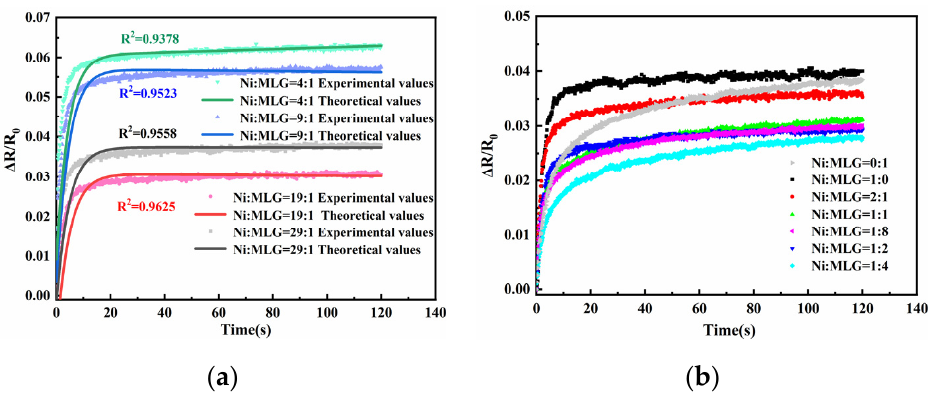
Figure 8. ( a ) Filling particle ratio vs. sensing unit resistance creep when the majority of the filling